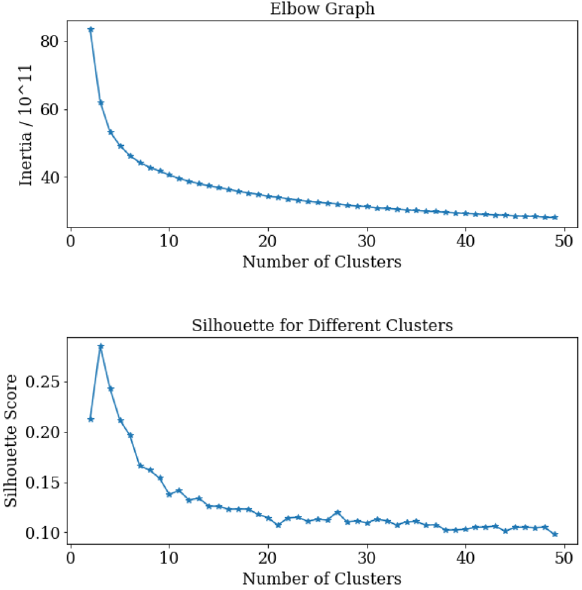
Figure 4. Elbow graph and silhouette score by cluster number generated from K-Means on codon usage frequency data. Listed are clusters 2 through 50. The inertia and silhouette pattern highlights the most intuitive clustering pattern at k = 3 with decent values for our kingdom sets k = 5 (analogous to our set of kingdoms) and k = 11 (analogous to the original set in the CUTG